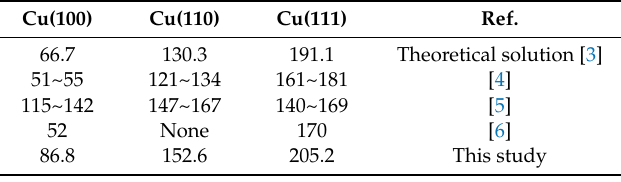
Table 3. A comparison of crystal-oriented elastic moduli for atomic-scaled Cu metal extracted from theoretical values, experimental data, and the simulated results of ACM-FEA presented in this study. (Unit: GPa).